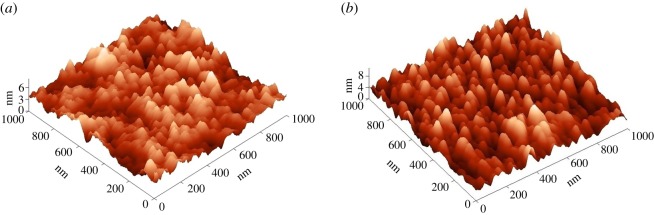
AFM images of TiO2 thin films deposited on window glass at (a) 350°C and (b) 450°C and annealed at 500°C for 1 h.